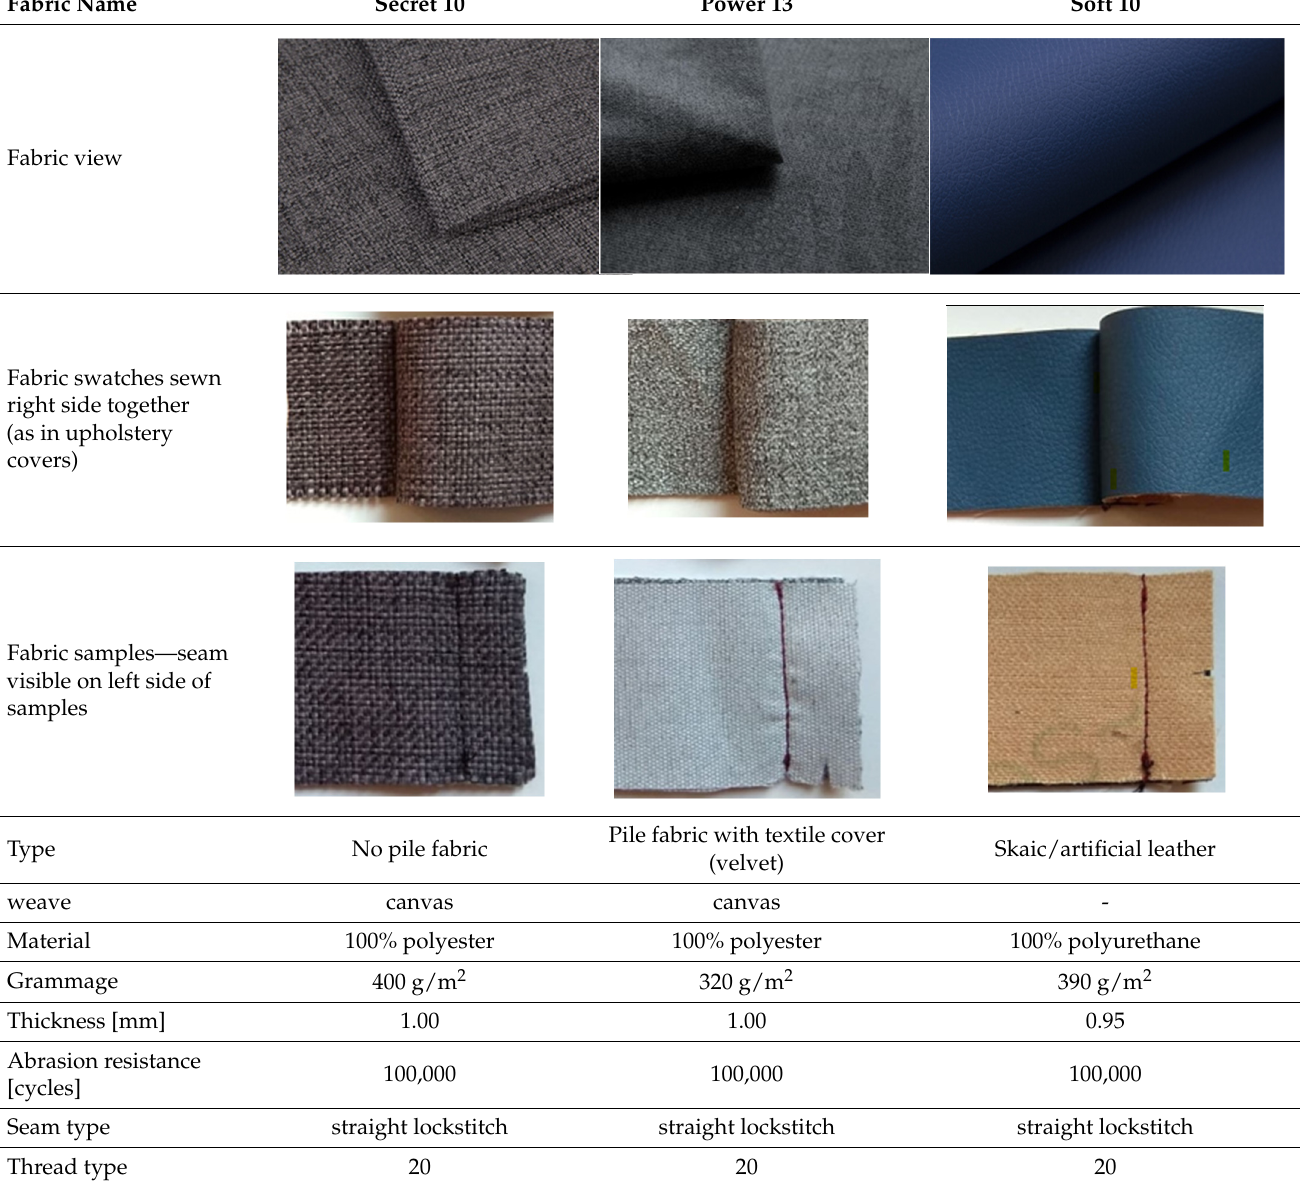
Table 1. Characteristics of selected upholstery fabric types.